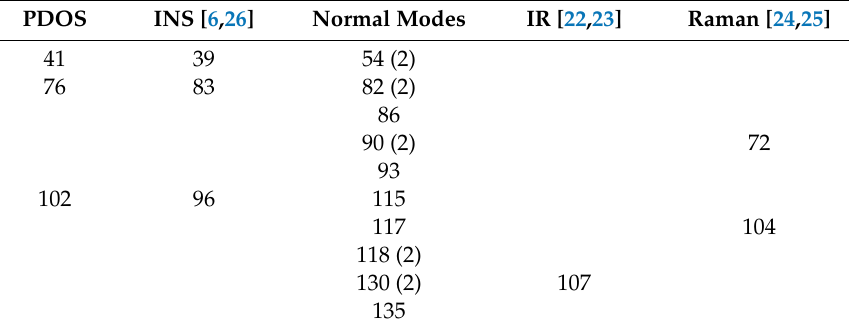
Figure 1. Simulated spectrum of ice II. The four images correspond to four vibration bands: translation, libration, bending, and stretching. From top to bottom: phonon density of states (PDOS), IR, and Raman spectra. Weak peaks have been amplified reasonably. Table 1. Comparison of calculated results with inelastic neutron scattering (INS), IR, and Raman data. The main peaks of phonon density of states (PDOS) in the first column are compared against the INS spectrum. Normal modes (numbers in brackets indicate the degeneracies) are compared against experimental IR and Raman peaks. The values are expressed in cm − 1